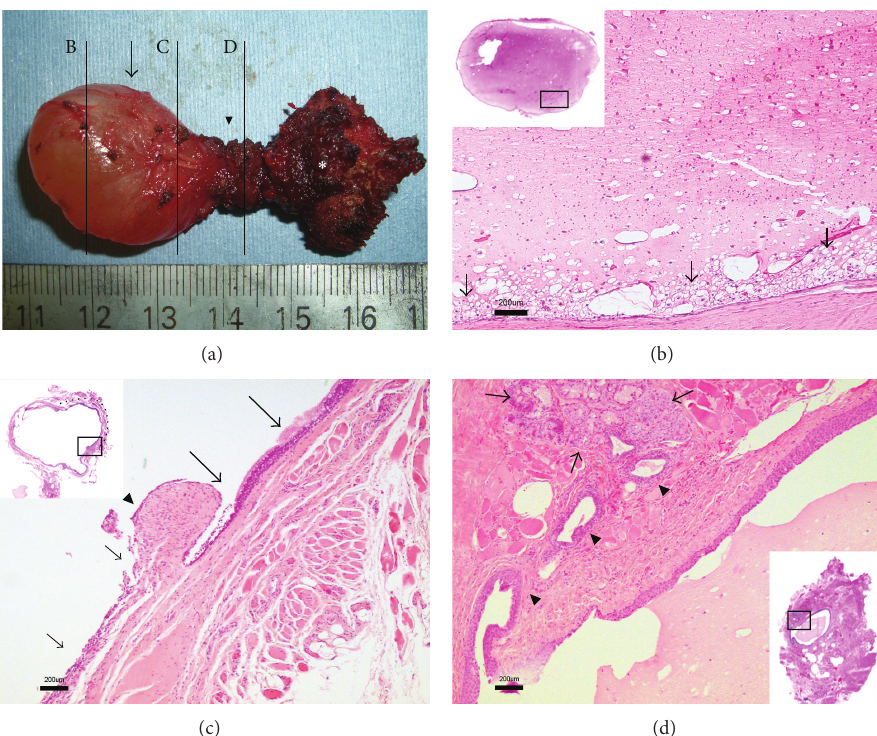
Figure 2: The thyroglossal duct and cyst. (a) The extirpated specimen consists of a 20 × 20 × 15 mm cyst (arrow), the bridging tract (arrowhead), and the middle third of the hyoid bone (asterisk). The perpendicular lines indicate the following three sections (B, C, and D). (b) Extravasation mucocele. Microscopic examination of the specimens through line B shows a nonepithelial lining cyst (hematoxylin- eosin stain; bar = 200 𝜇 m). Note that there are numerous foamy histiocytes (arrows) adjacent to the nonepithelial lining wall of the cyst. (c) Associated ruptured cyst. Microscopic examination of the specimens through line C shows an associated ruptured cyst (hematoxylin-eosin stain; bar = 200 𝜇 m). This section is composed of two different parts: the ciliated respiratory epithelium (large arrows) and the no epithelial lining (small arrows). Note the puckered distinct border between these parts (arrowhead), which might have resulted from the rupture of the cyst. The dotted line indicates the presence of the epithelial lining. (d) Thyroglossal duct. Microscopic examination of the specimens through line D shows the thyroglossal duct with transitional epithelium lining and the presence of heterotopic salivary glands (arrows) and ducts (arrowheads) draining into the thyroglossal duct (hematoxylin-eosin stain; bar = 200 𝜇 m).